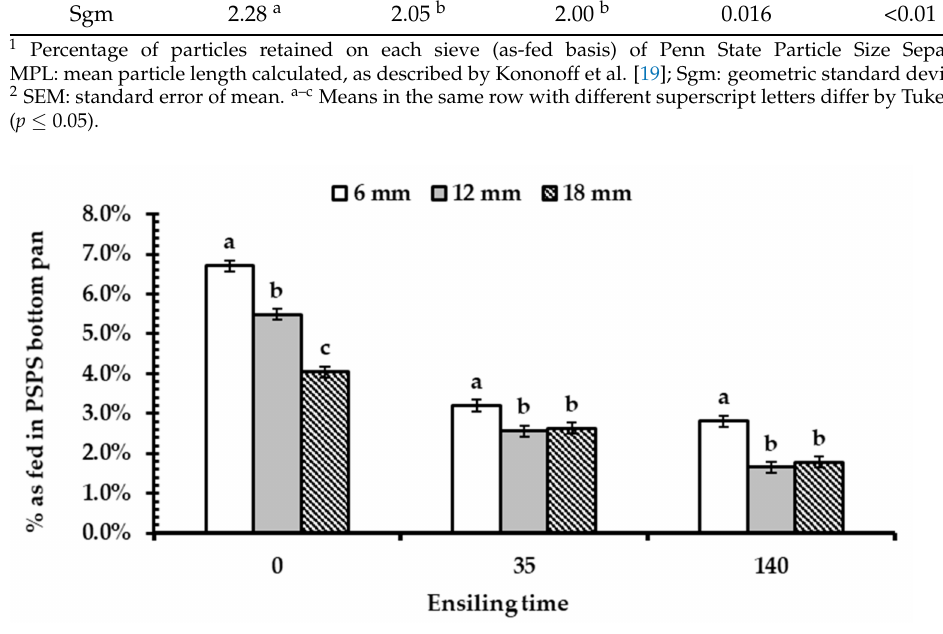
Figure 1. Interaction between theoretical length of cut and ensiling time (day) for particles in the Penn State Particle Size Separator bottom pan ( p = 0.01; SEM = 0.08) in whole-plant corn silage harvested with a self-propelled forage harvester. SEM: standard error of mean. a–c Means in the same ensiling time with different superscript letters differ by Tukey test ( p ≤